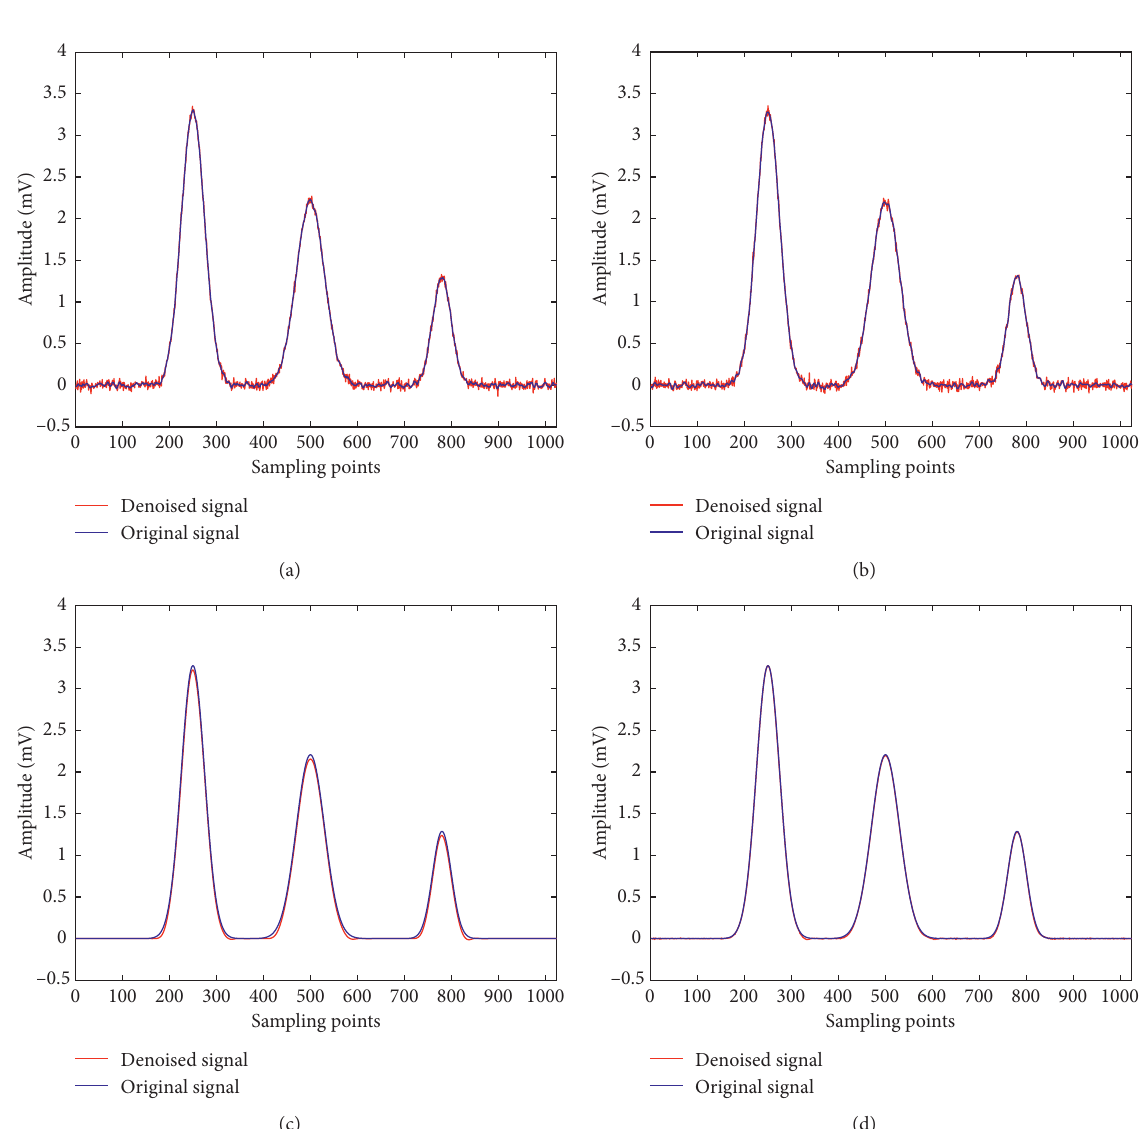
Figure 8: The results of simulation signal denoising of 29dB by different methods. (a) Savitzky–Golay. (b) Fast Fourier Transform. (c) Soft threshold method. (d) The proposed